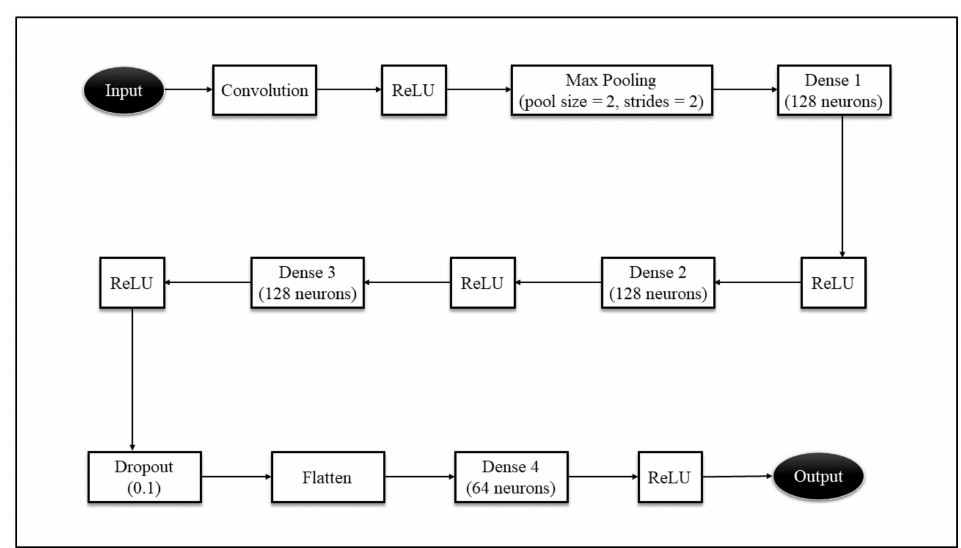
Figure 5. The detailed block of the 1D-CNN architecture for the SRT dataset after the configuration of the